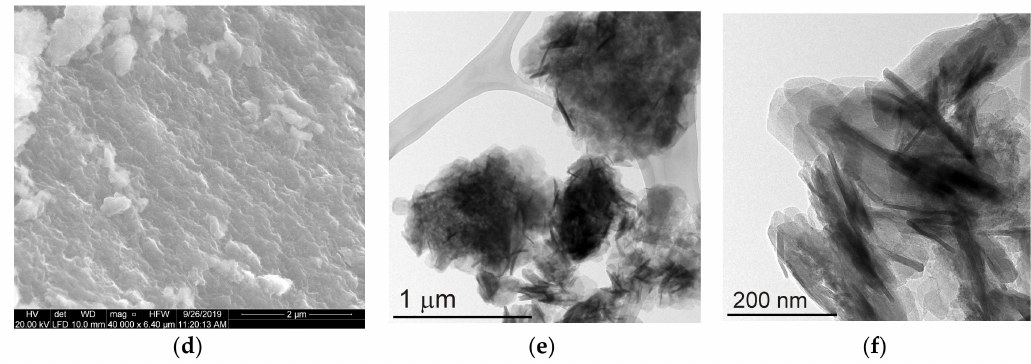
Figure 4. SEM and TEM images of LDH materials: ( a – c ) Mg-Al-Cl-2 and ( d – f ) Mg-Fe-Cl-2.